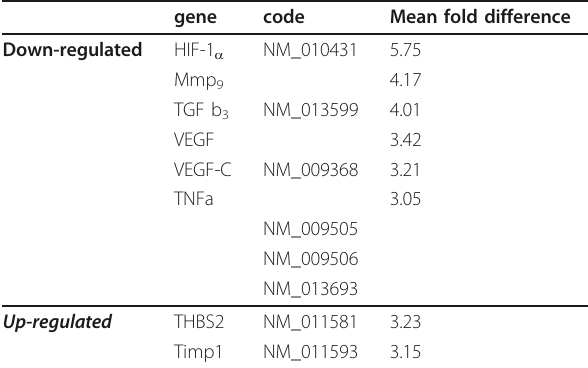
Table 2 Angiogenesis-related Genes Significantly Affected by Sal B in SCC4